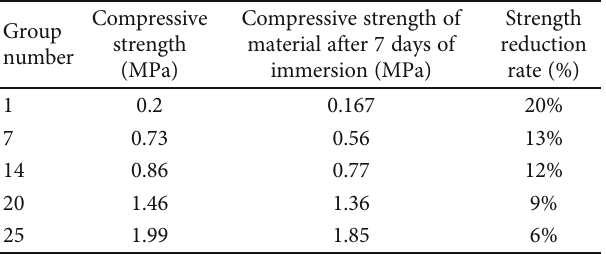
Figure 5: Stress-strain curve of 14 groups of similar materials. Table 2: Strength comparison of some samples in natural state and after immersion.